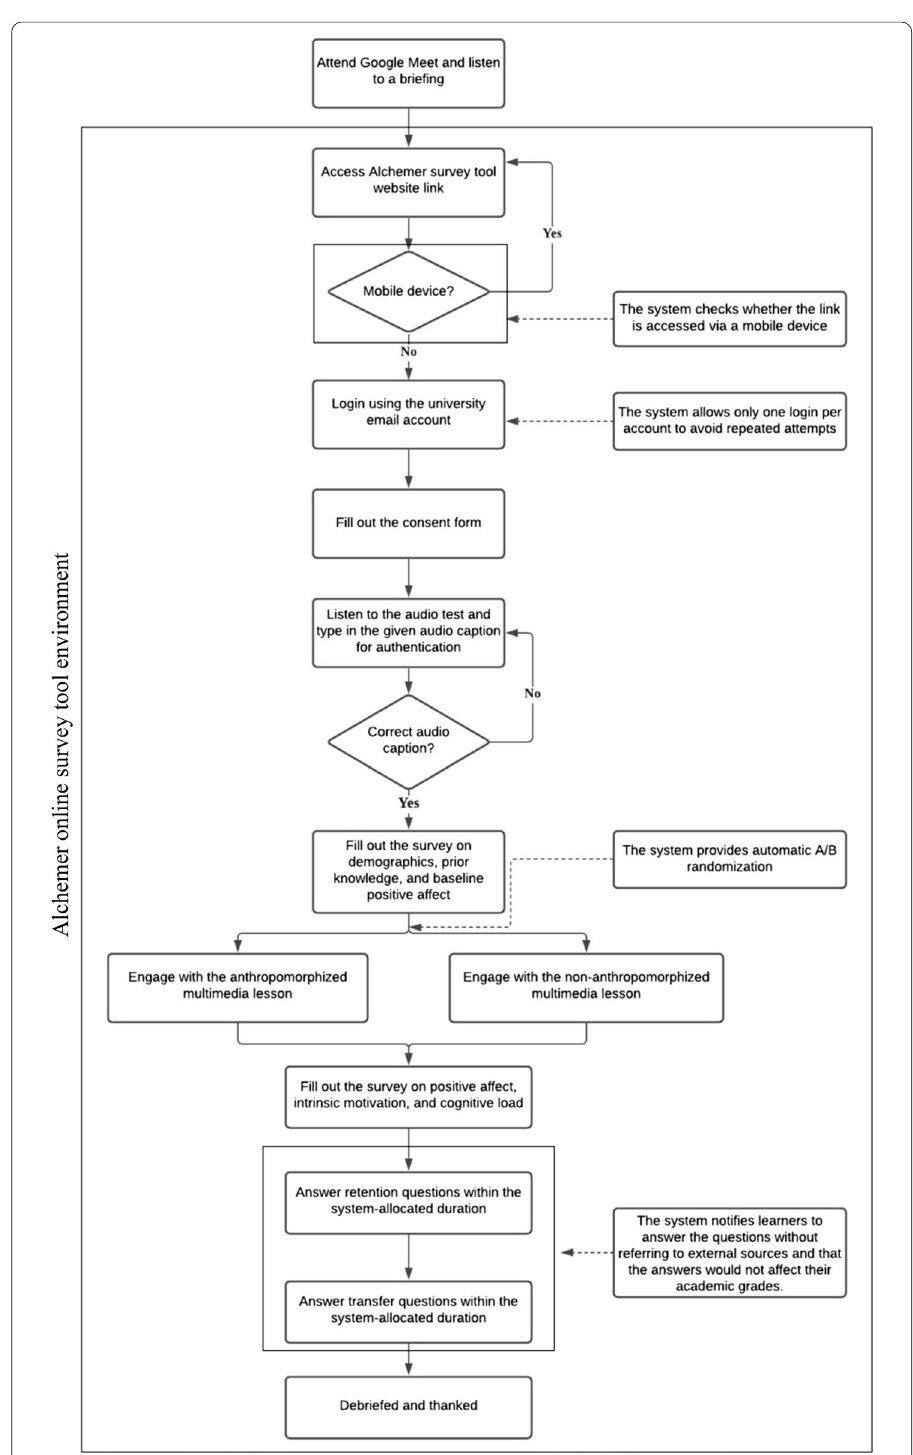
Fig. 2 Flowchart of a learner’s experimental